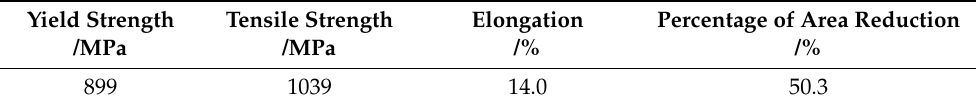
Table 2. Tensile properties of TC4 alloy initial material.